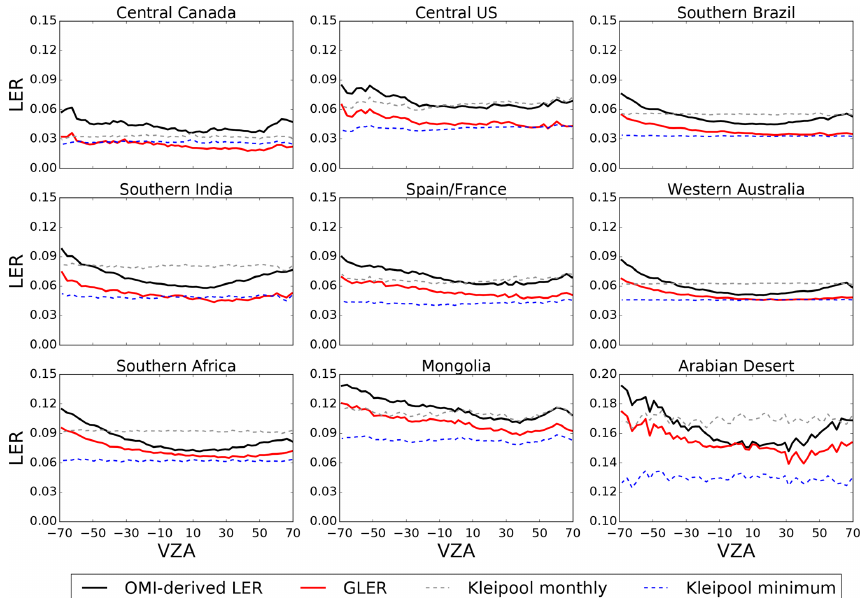
Figure 9. Cross-track (or VZA) dependence of OMI-derived LER (black line), GLER (red line), and Kleipool et al. (2008) climatological LER (dashed line) for June–August 2006 (December–February 2006 in southern India) across various geographical regions screened for clouds and aerosols. Positive (negative) VZAs denote forward (backward) scattering directions.